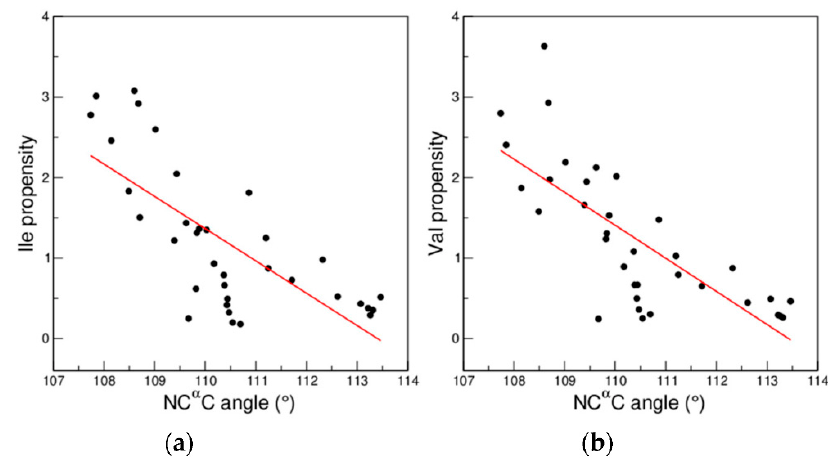
Figure 11. Propensities of ( a ) Ile and ( b ) Val residues as a function of the average value of the backbone bond angle τ (NC α C) of the ( φ , ψ ) boxes. Significant anticorrelations have been detected for both Ile (R = − 0.73, p < 10 − 5 ) and Val (R = − 0.76, p < 10 − 5 ) residues. Amino acid residue propensities and NC α C values were calculated in the dataset Data1.6. Only boxes containing more than 500 residues were considered.